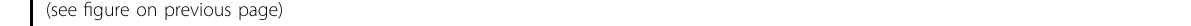
YAP1 , the key activator and central component of this pathway, was signi fi cantly increased in C0, C1 and C3 subclusters of CSCs, as well as CBCs and CSfCs (Fig. 6b). Immunohistochemical staining con fi rmed the elevated expression of YAP1 in both corneal stroma and epithelium (Supplementary Fig. S10a).